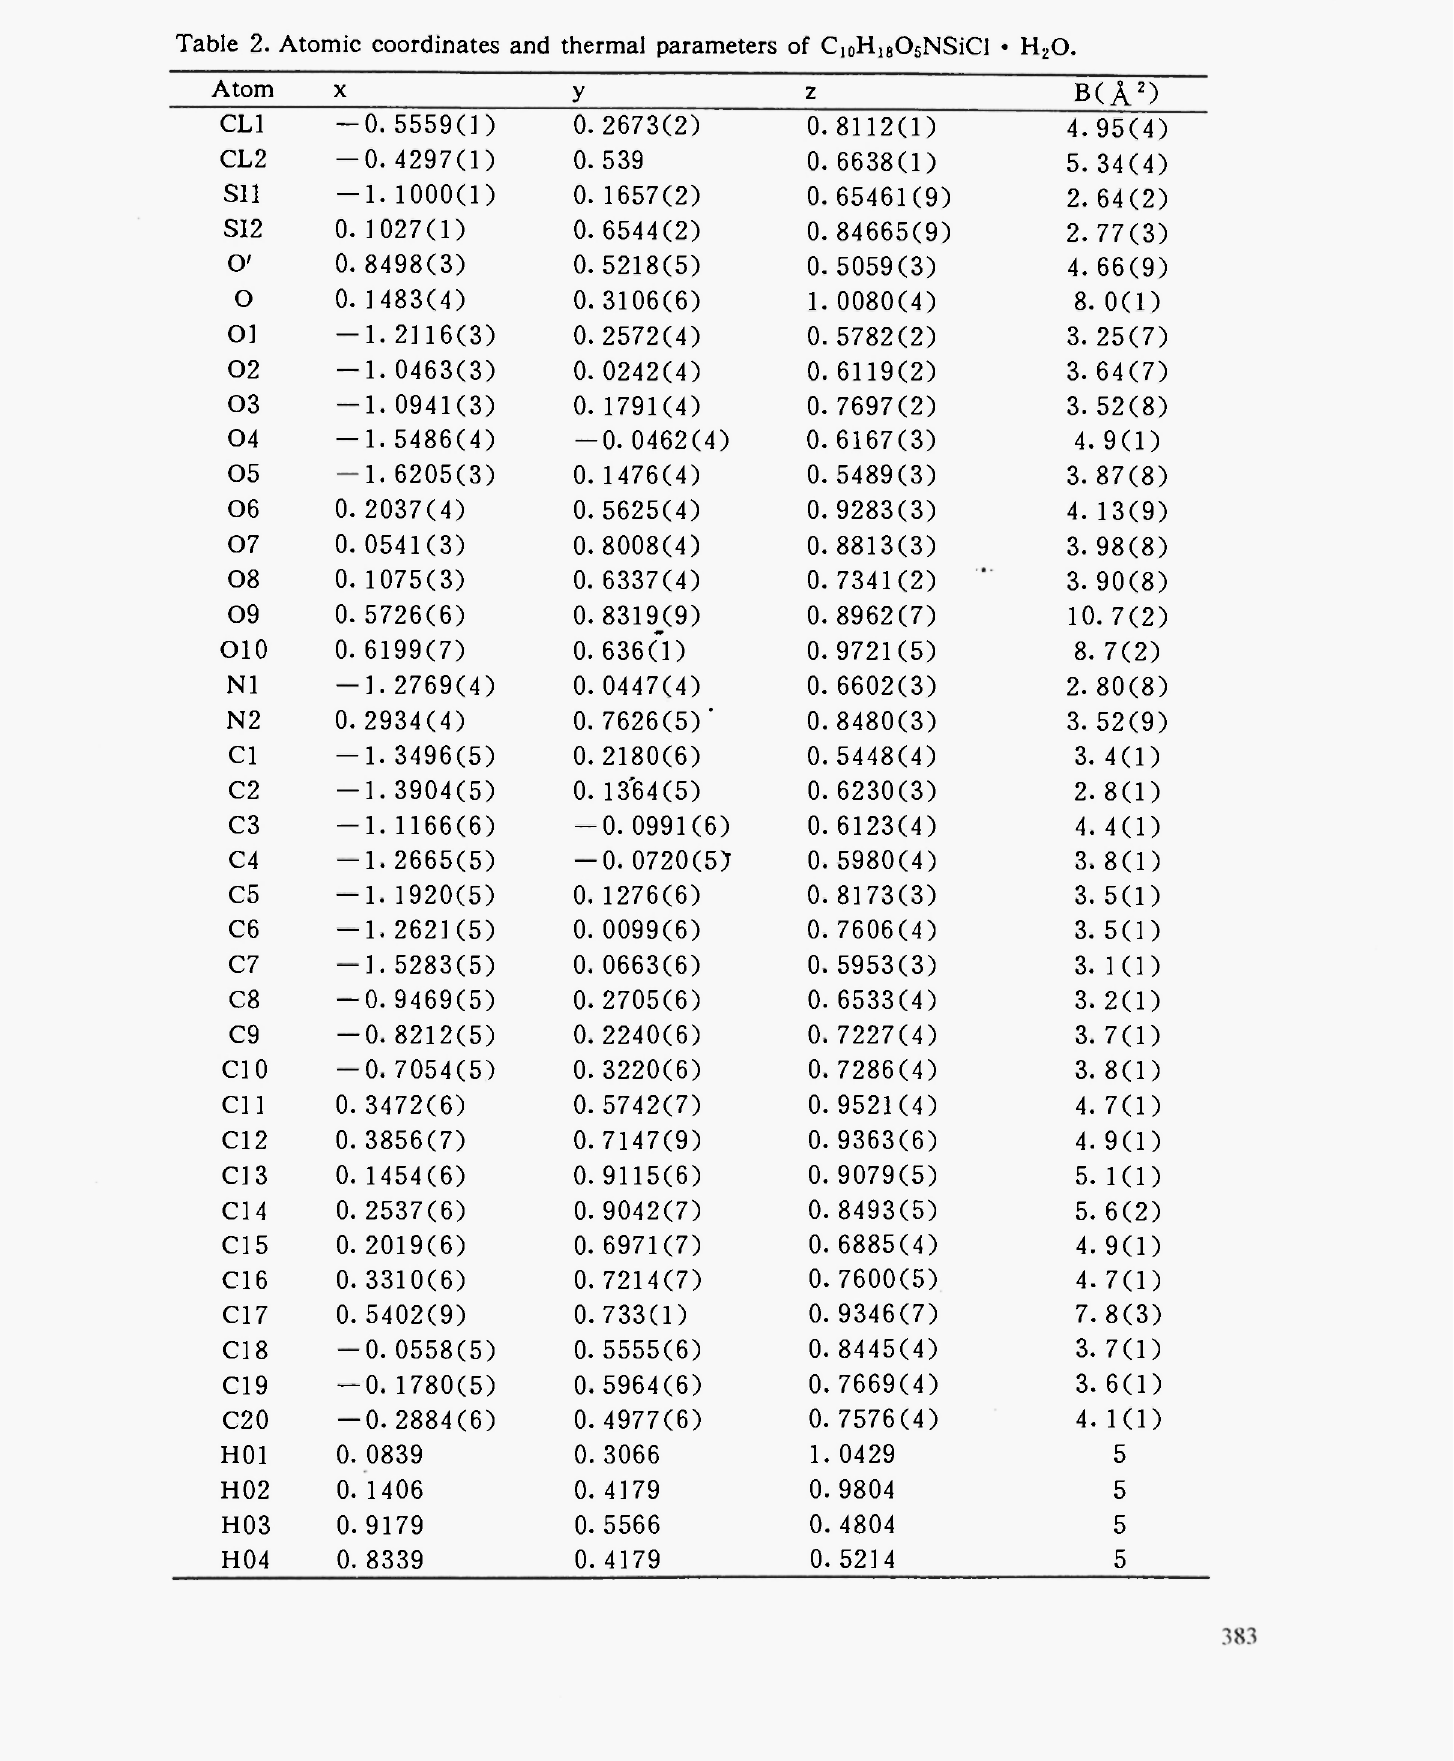
Table 2. Atomic coordinates and thermal parameters of C